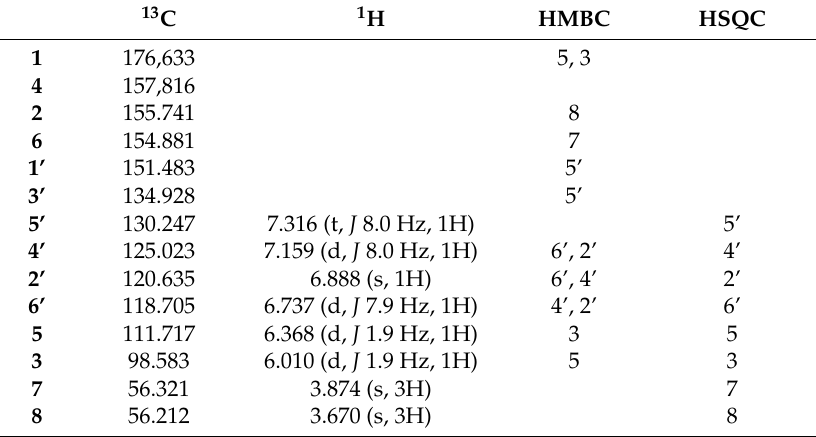
Figure 1. Structure of synthetized compounds 3a–j 2,6-dimethoxy-4-(phenylimino)cyclohexa-2,5-dienone derivatives. Table 2. 1 H- and 13 C- chemical shifts assignments for compound 3b. Information from HSQC and HMBC experiments are also provided.